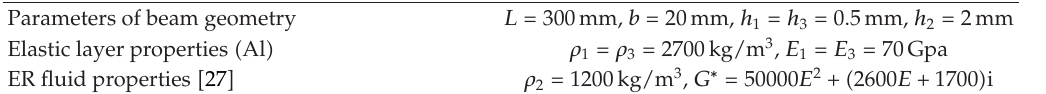
Table 3: Parameters of ER sandwich beam. Parameters of beam